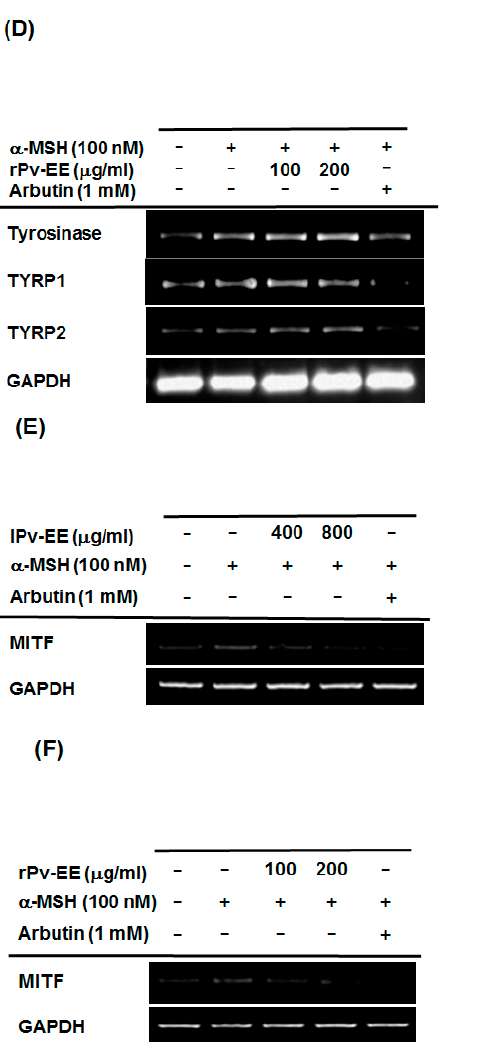
Figure 2. Effect of lPv-EE and rPv-EE on the MITF mRNA expression condition in α -MSH-treated B16F10 cells. ( A , B ) The effect of lPv-EE (400 to 1600 μ g/mL), rPv-EE (100 and 200 μ g/mL), or kojic acid (300 μ M) on mushroom tyrosinase activity was determined by quantifying the activity of purified tyrosinase. ( C–F ) The mRNA levels, as determined by RT-PCR, of B16F10 cells treated with 100 nM α -MSH and lPv-EE (400 or 800 μ g/mL) or rPv-EE (100 or 200 μ g/mL) or 1 mM of arbutin for 24 h.